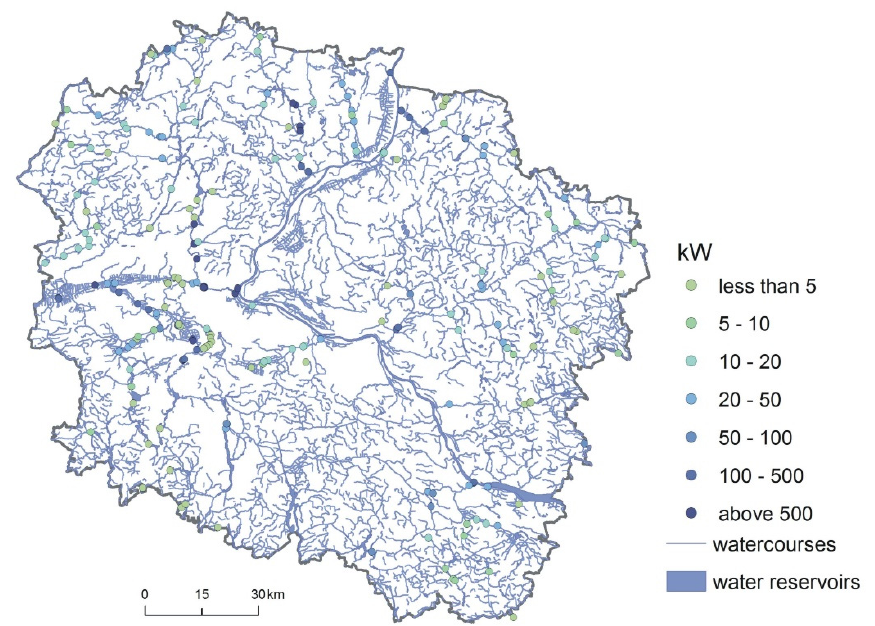
Figure 7. Localization of water dams and power of the potential hydropower plants in the Kujawsko-Pomorskie voivodeship (own elaboration). The power of all the potential hydropower plants in the Lubelskie voivodeship on dams is 9.0 MW (Figure 8).